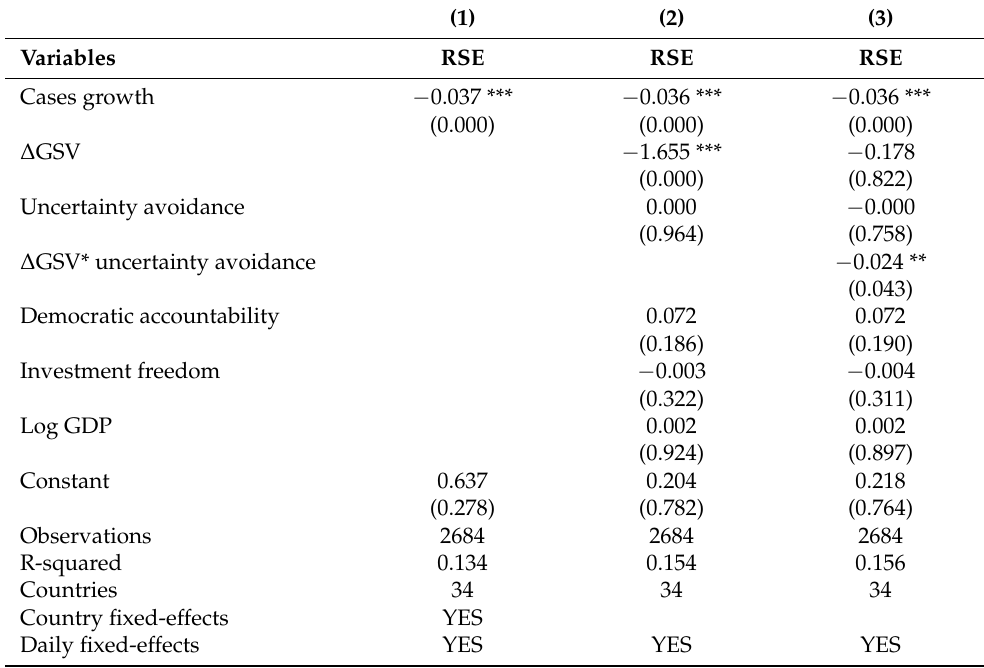
Table 3. Panel regression